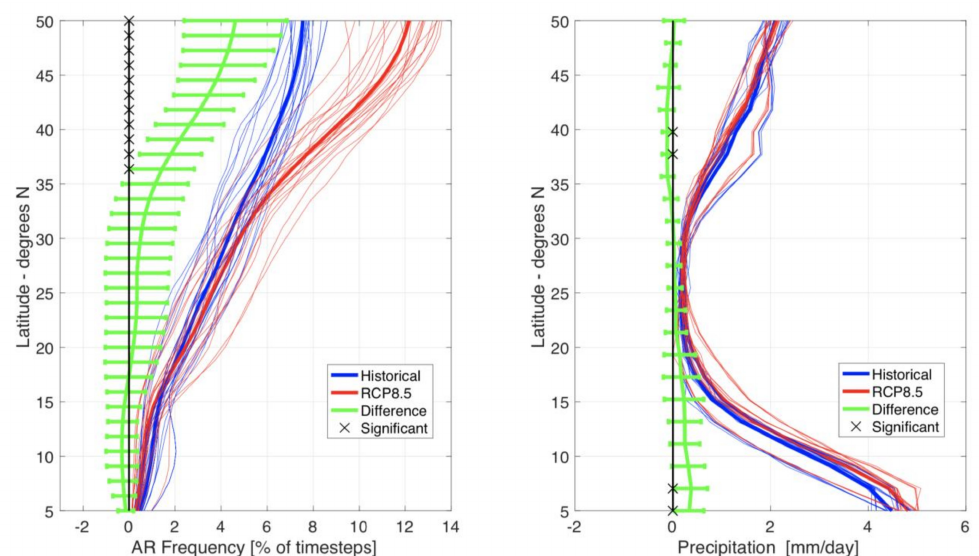
Figure 10. Multi-model ensemble for the CMIP5 historical simulations (blue), the RCP85 simulations (red), and the di ff erence bars showing 95% significance range for the projected di ff erences (green), and latitudes with statistical significance marked with a black ‘x’. The 95% bounds are determined using 2 times the standard deviation of the multi-model ensemble spread. These plots are shown as latitudinal averages. ( Left ) This panel shows the AR frequency plots, and areas with higher latitudes than 35 N are expected to see significant increases in AR frequency in the future. ( Right ) This panel shows the precipitation plots, showing an expected increase in precipitation from 5–20 N, and slight decrease in precipitation around 40 N. These results coincide with the regions highlighted in Figure